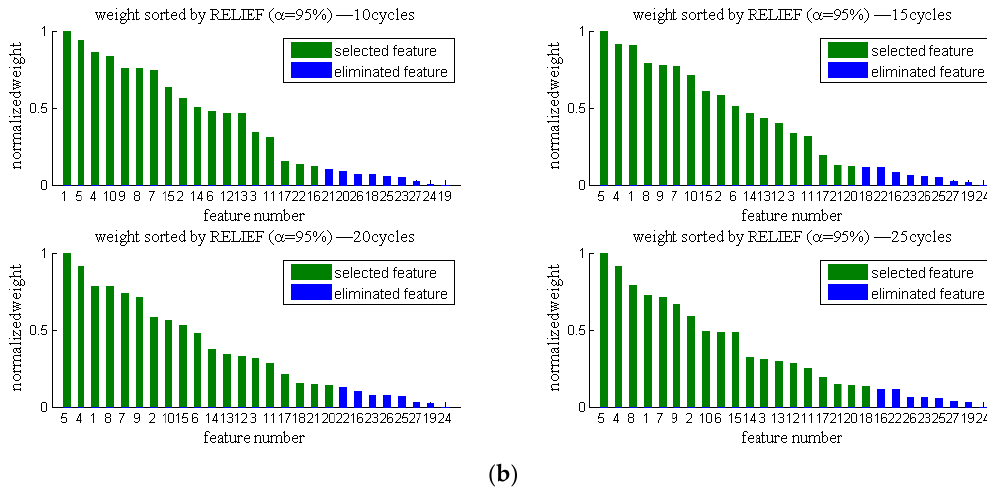
Figure 5. Normalized weight rankings of the features obtained by RELIEF (range [0, 1]) for different sampling cycles. ( a ) Rotor Angle; ( b ) Voltage Magnitude.